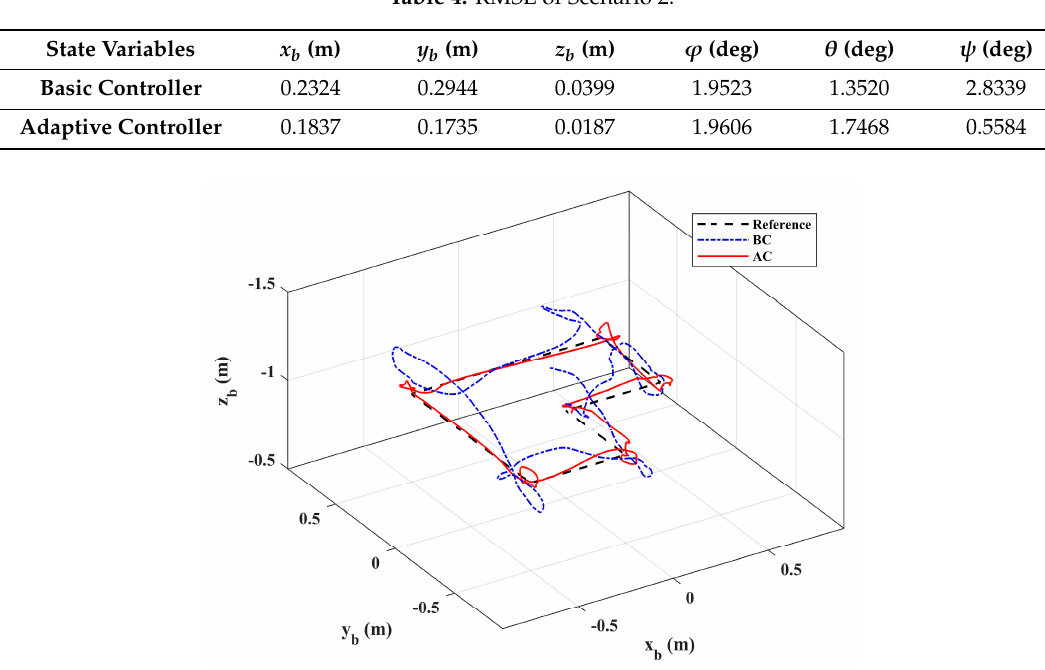
Figure 16. Control inputs of Scenario 1 and Scenario 2. 4.3. Contact Test Results and Analyses The contact test was carried out in scenario 3. Set the vertical wall at the lateral direction of +1.8 m, and give the desired position references of the end effector to drive the end effector approach and contact the wall along the lateral direction, while x e,d and z e,d remained stationary. In order to achieve stable contact between the end effector and the wall, the lateral reference position y e,d was set at 1 cm behind the wall. During the test, for the given references of the end effector, the references of the aerial platform and the manipulator were obtained by the motion planner module in the controller. First, the aerial platform was driven to fly near the wall so that the distance between the end effector and the wall was less than 0.2 m, then the platform remained hovering and the arm extended forward to achieve physical contact. Figure 17 shows the end effector’s position responses. The whole process can be divided into four stages: aerial platform approaching, manipulator extending, docking, and continuous contacting. The right half blue part in Figure 17 and also Figure 18 denotes the interaction process with the wall. Notice that for safety, the test based on the ordinary PID controller was not carried out, only the test based on the impedance controller was performed.